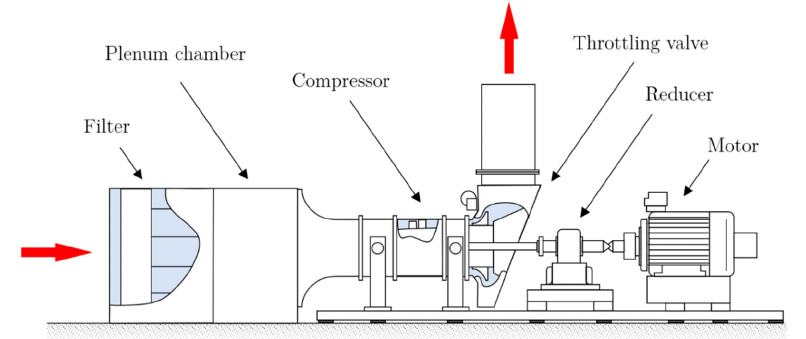
Figure 1. CME2 axial compressor.